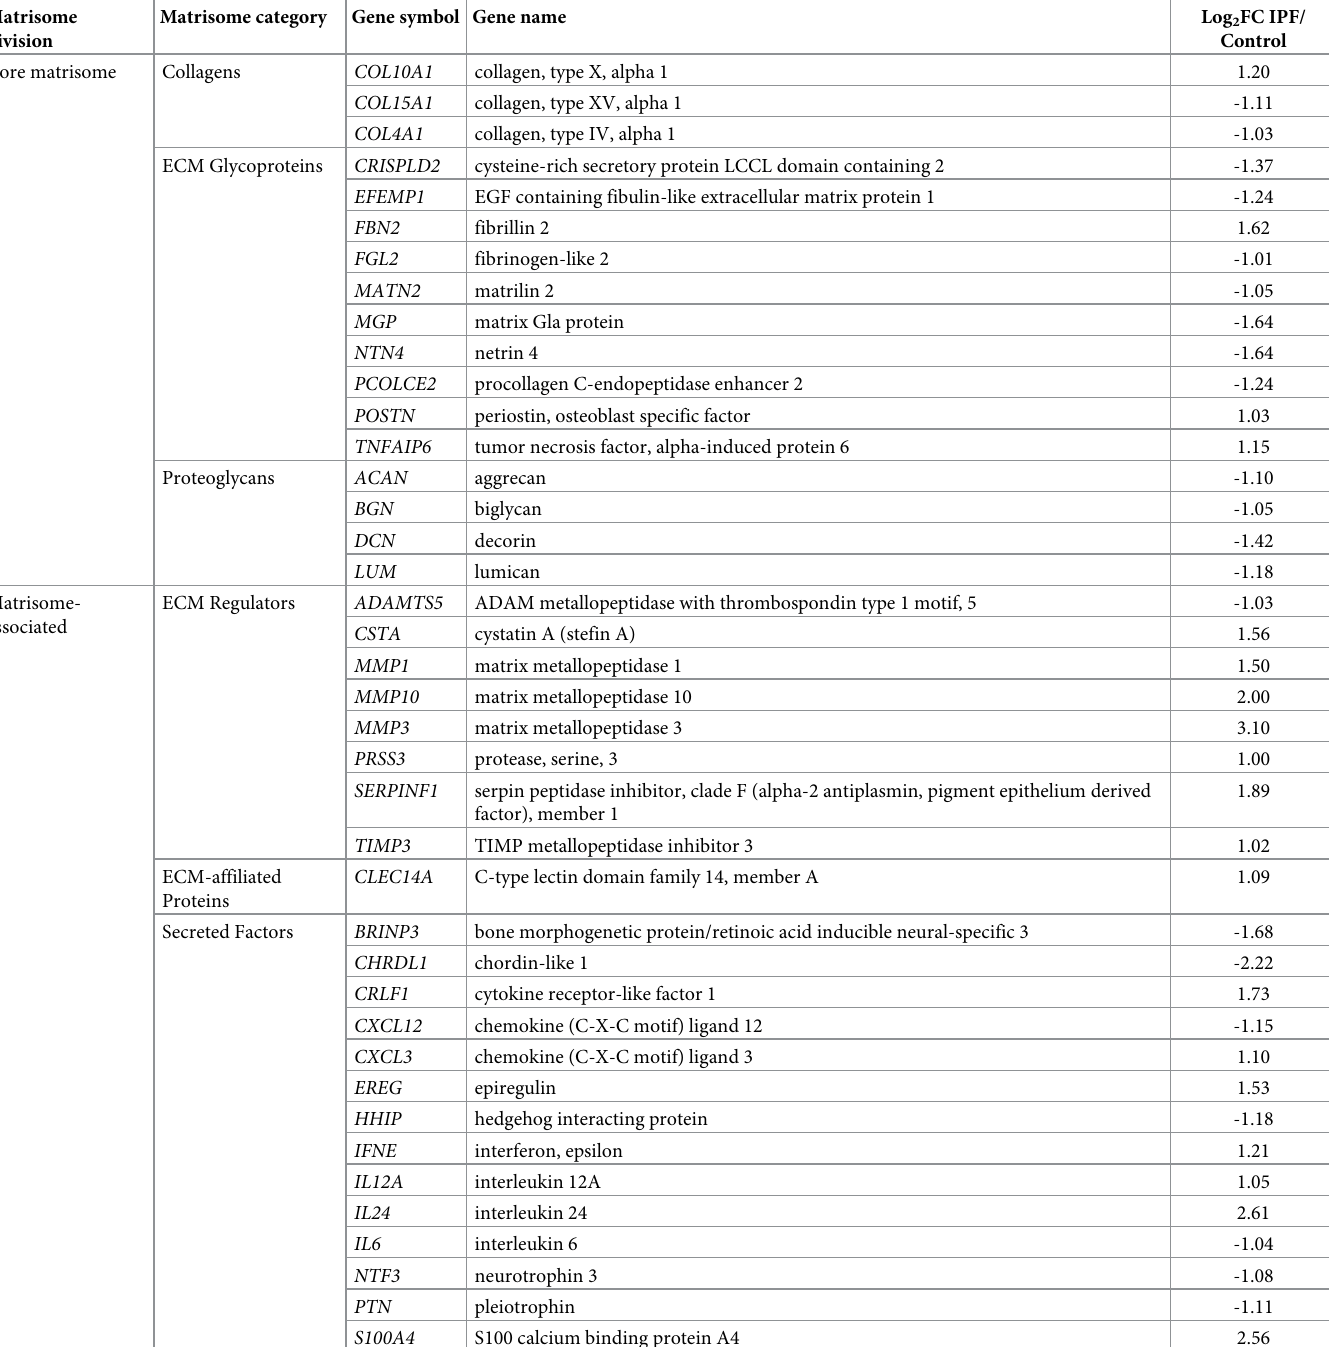
Table 2. Differentially expressed matrisome genes in stromal cells derived from IPF compared to normal lung. Matrisome